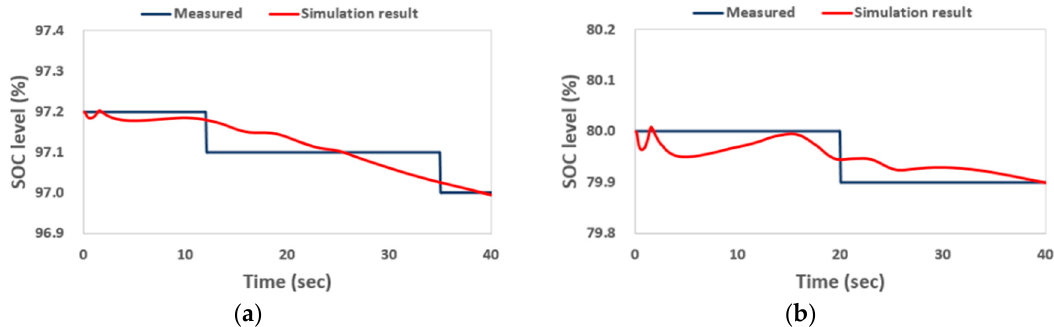
Figure 10. Comparison of averaged SOC level of ( a ) left battery and ( b ) right battery for measured and simulated results at a ground speed of 10 km/h under on-road conditions.